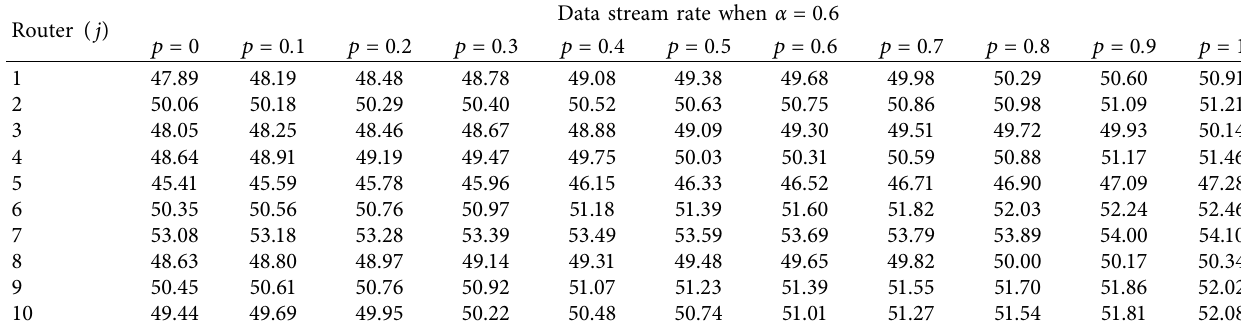
Table 7: Data stream rate for different values of p and α � 0 . 6.